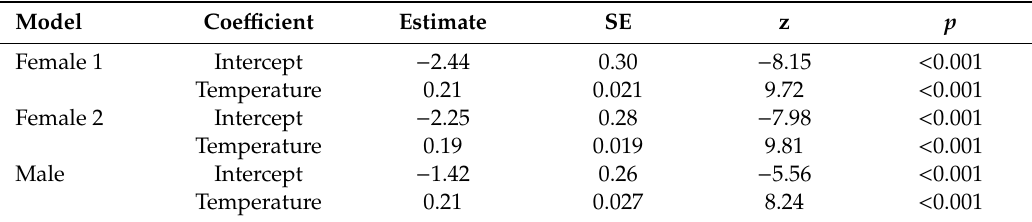
Table 4. Individual logistic regression models of shade use by three Sichuan